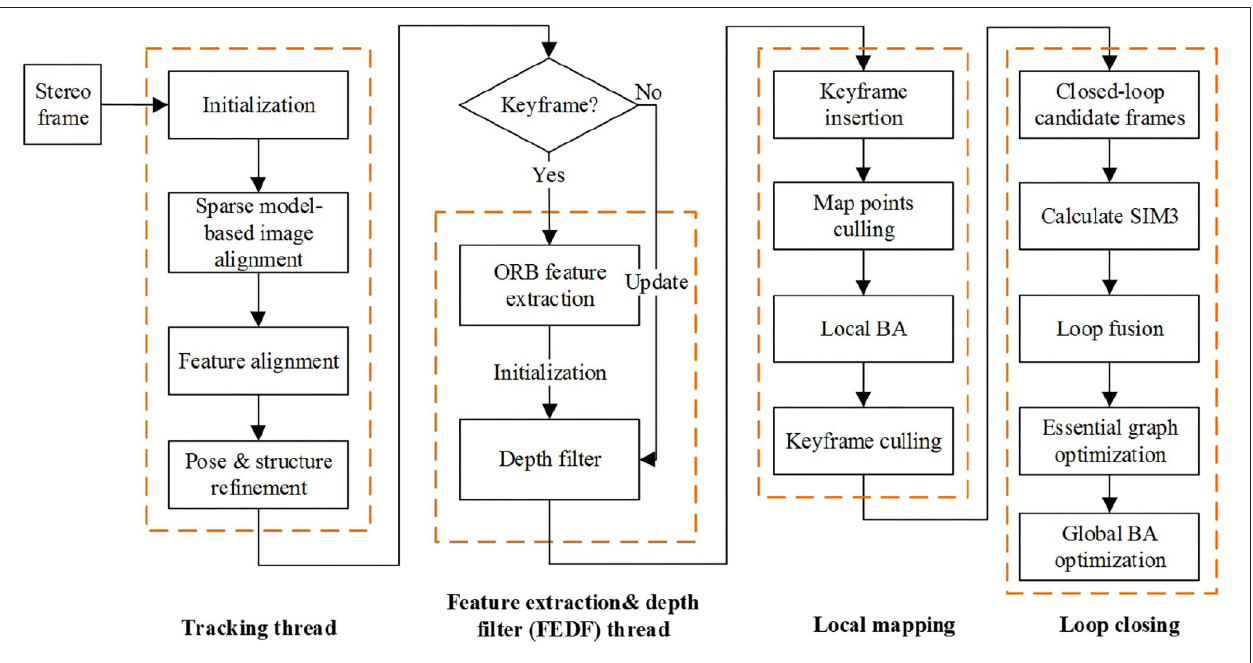
FIGURE 2 | The framework of the proposed localization algorithm.